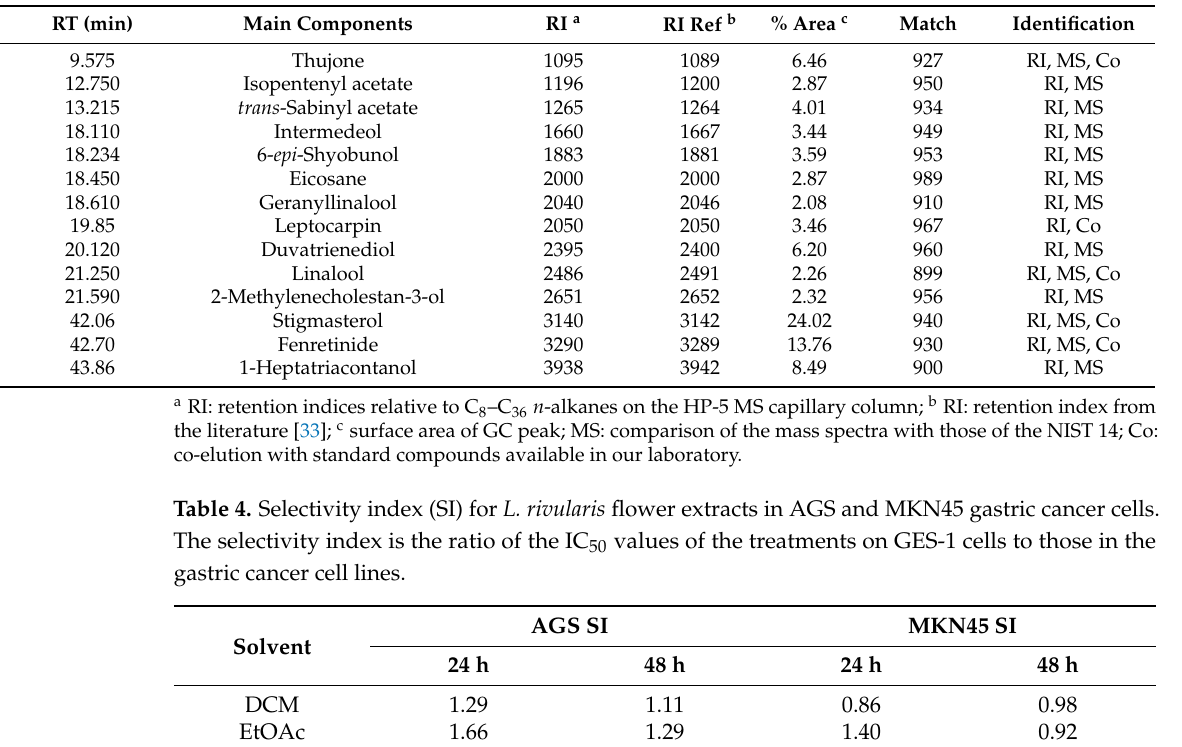
Table 3. Majority composition of EtOAc extract of L. rivularis flowers.